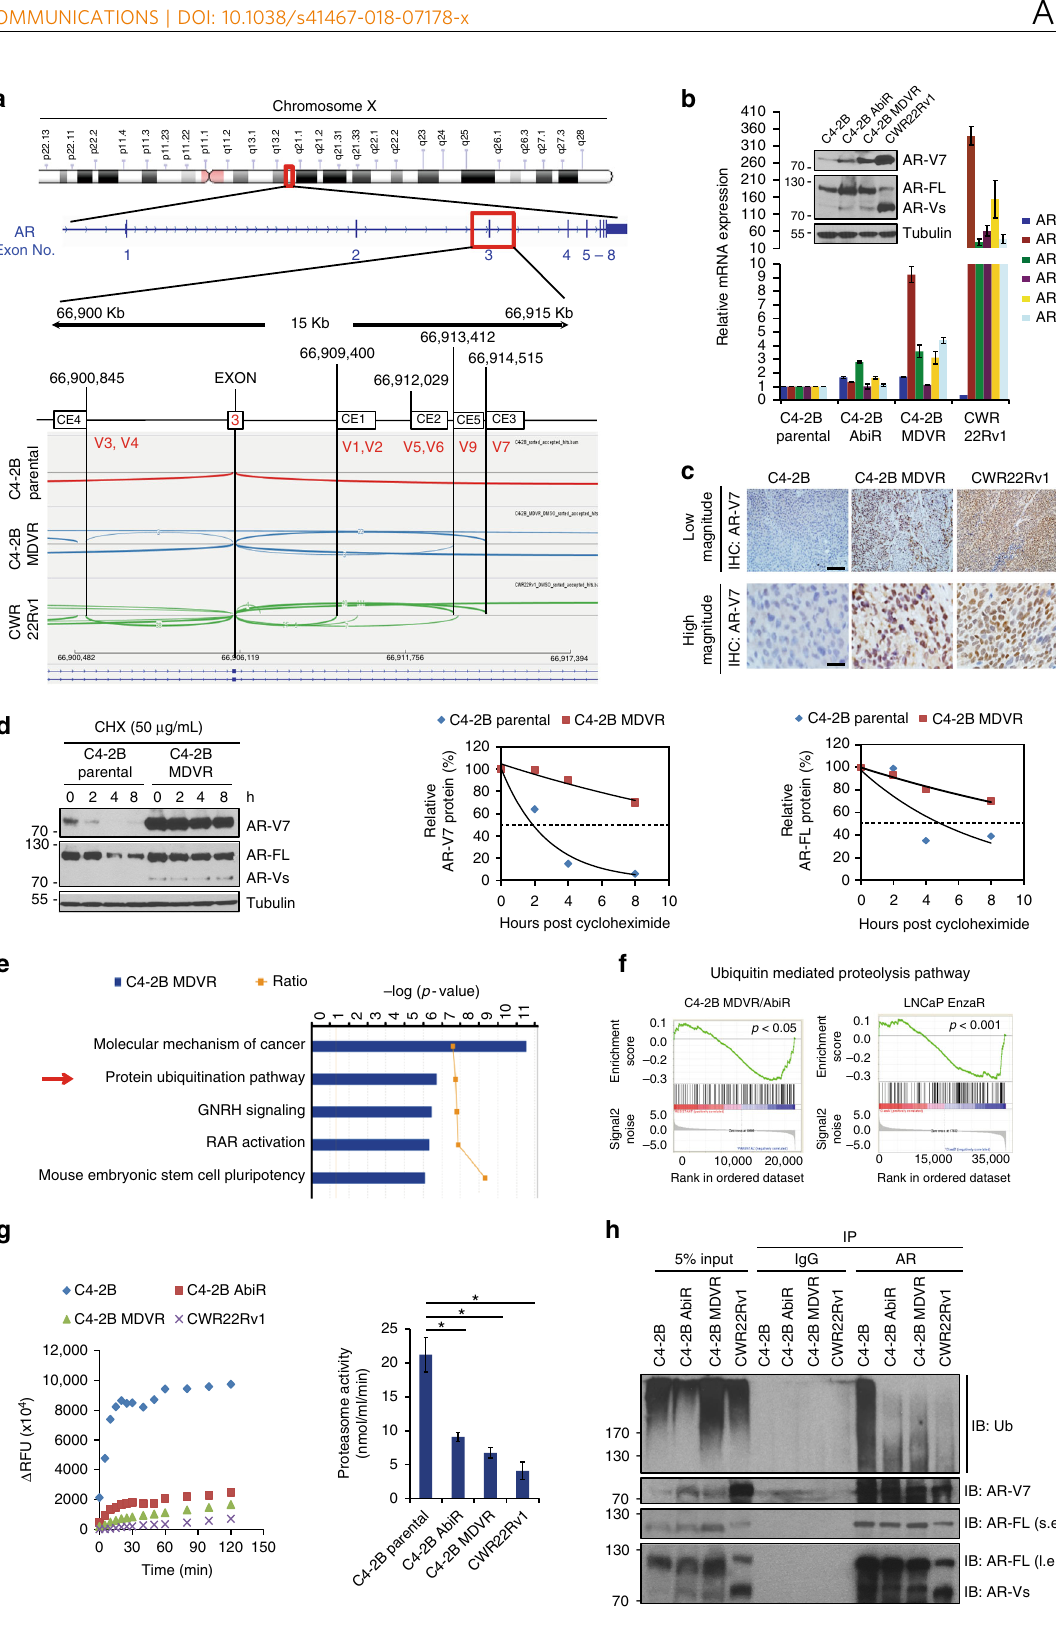
STUB1 and HSP70 (Fig. 2c, Supplementary Fig. 1c middle and bottom). Similar results showed that STUB1 and HSP70 bind to endogenous AR-FL and AR variants in both C4-2B MDVR and CWR22Rv1 cells (Supplementary Fig.